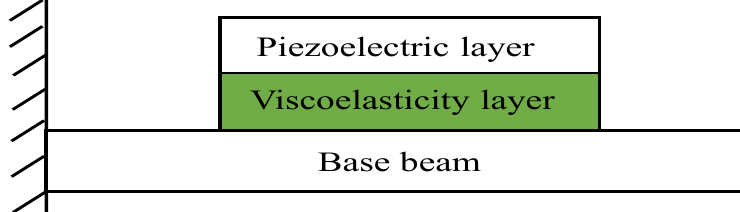
Figure 1. ACLD cantilever beam.